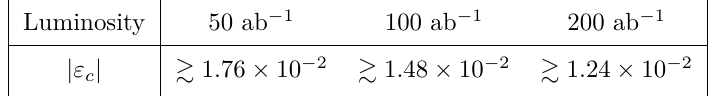
Table 4 . Sensitivities on ε c of 17 MeV X boson from ‘ + ‘ − J/ Ψ → ‘ + ‘ − e + e − η c search at Belle